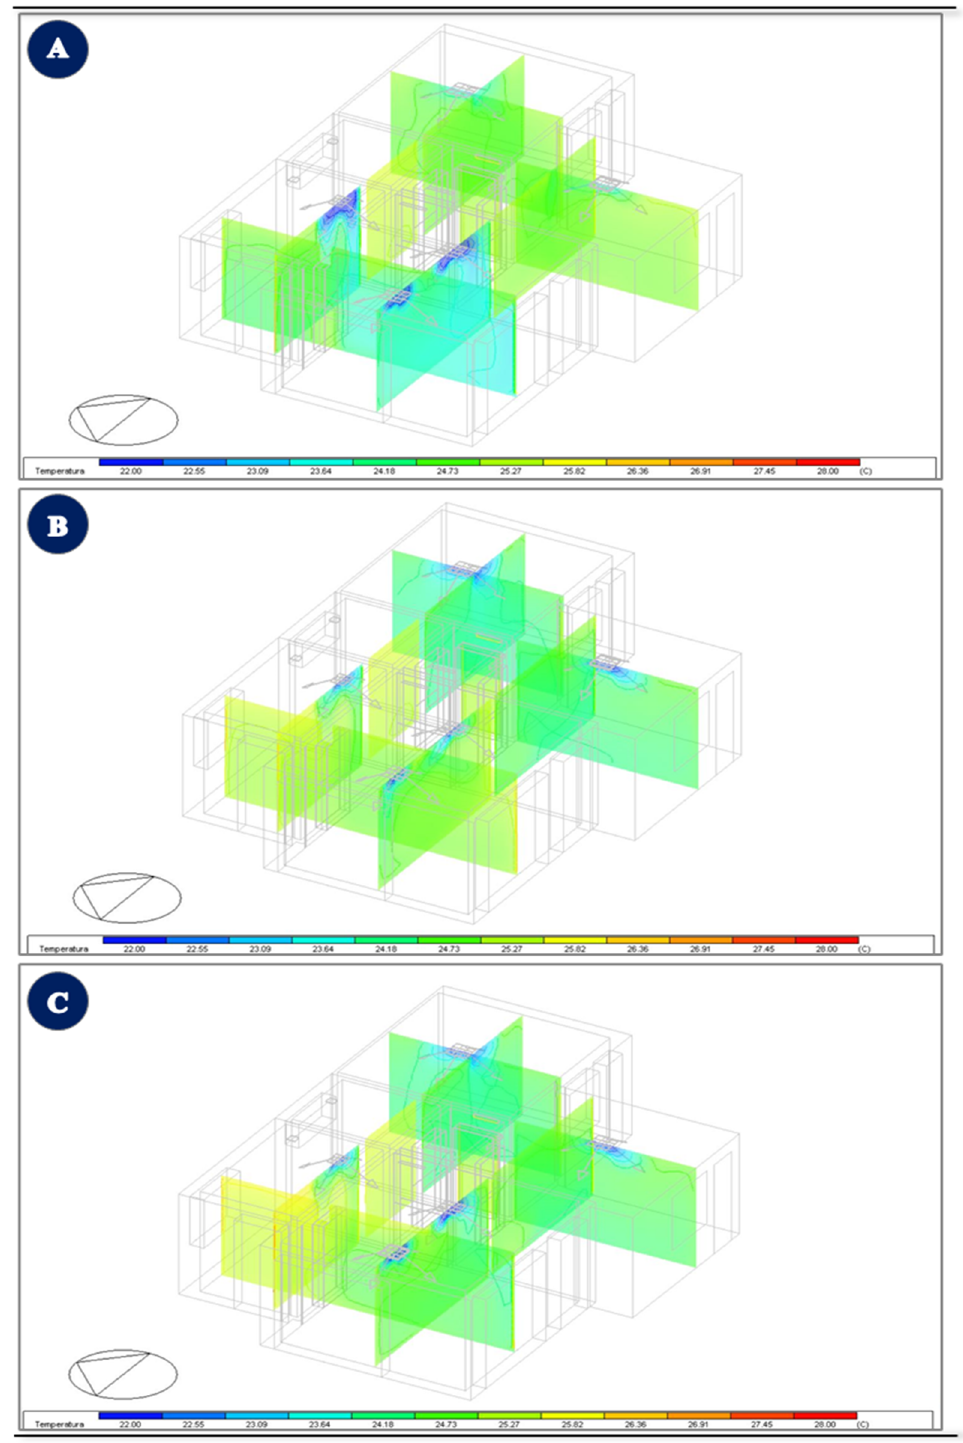
Figure 9. 2D distribution of air temperature on 24 July at ( A ) 10:00, ( B ) 14:00, and ( C ) 18:00.